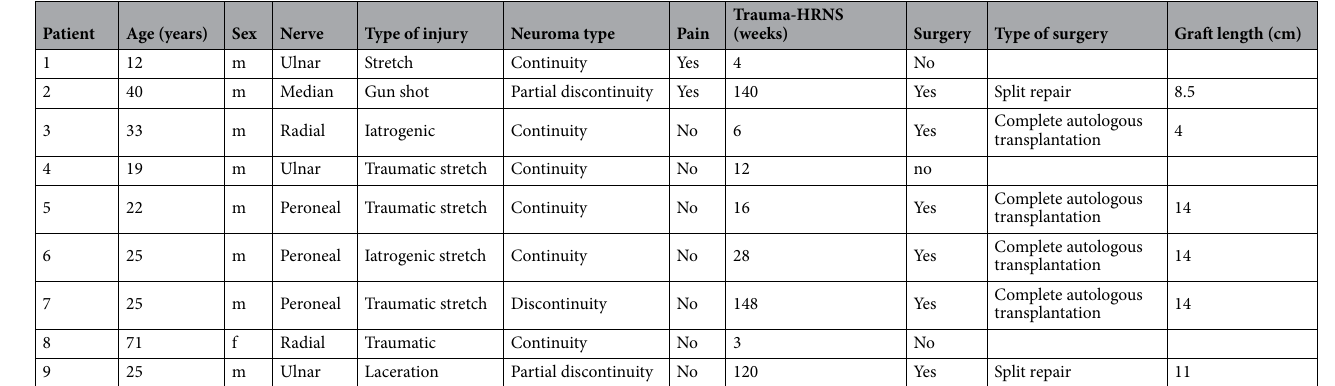
Table 1. Synopsis of the demographic and clinical patient